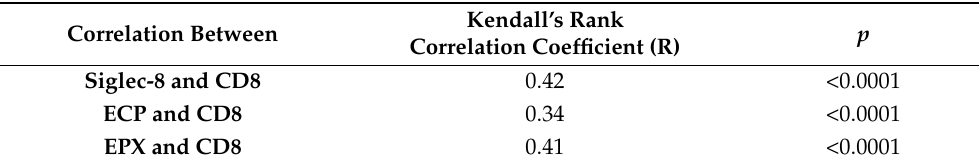
Table 2. Line-up of Kendall-Tau correlations between eosinophil markers (Siglec-8, ECP, EPX) and T-cell marker CD8.